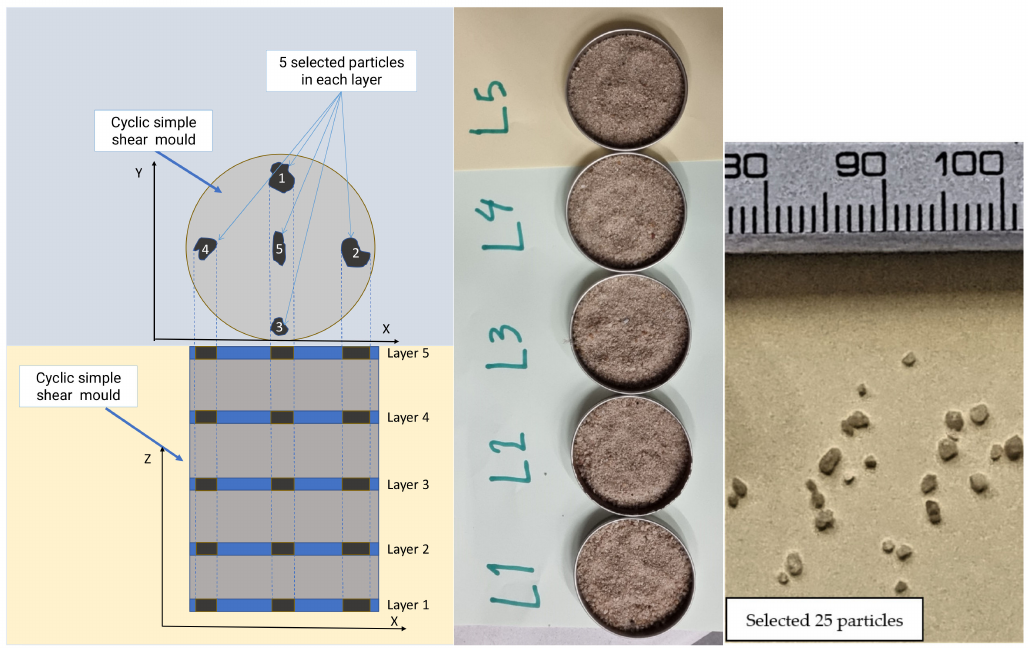
Figure 5. Illustration of the selection process for the 25 sand particles for each sample (not to